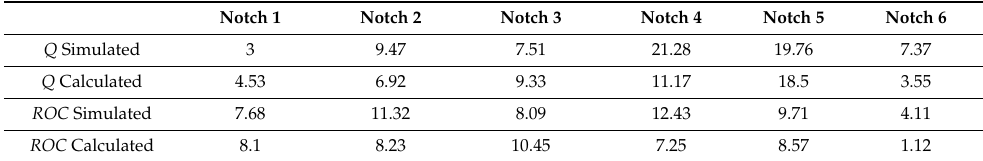
Figure 8. Comparison between simulated and calculated reflection coefficient. Table 3. Comparison between the simulated and calculated Q and ROC of the proposed